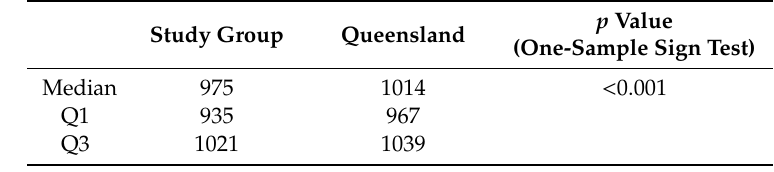
Table 1. Descriptive analysis of Index of Relative Socio-Economic Advantage and Disadvantage (IRSAD) scores of the postcode of dogs in our study and those determined for the population of Queensland.